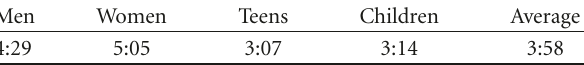
Table 1: TV viewing hours per day in 2003, FCC data.